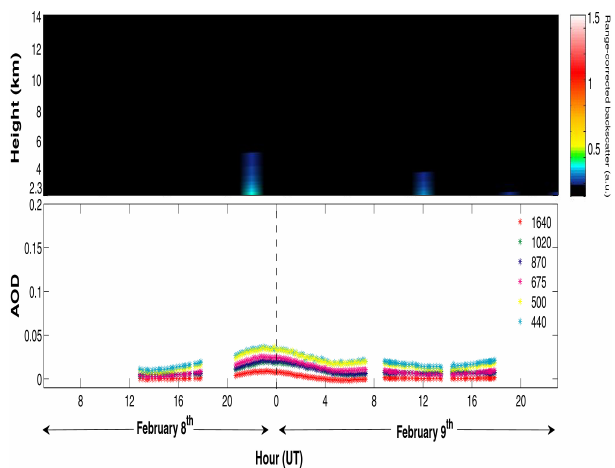
Fig. 4. CE-1 τ a on 8 and 9 February 2012, with MPL corrected backscatter cross-sections from the Iza˜na Observatory level.